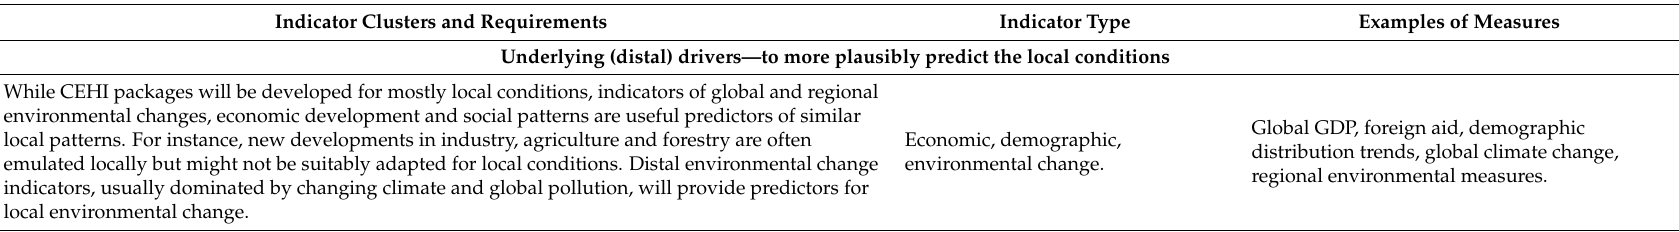
Table 2. Children’s environmental health indicator clusters, their indicators’ requirements, descriptions of indicator types, and broad examples of indicator